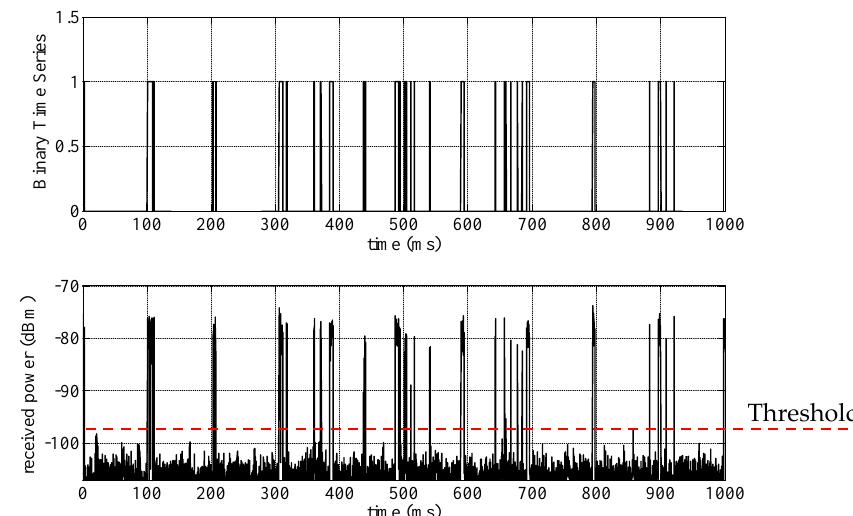
Figure 4. Mapping from received power to Binary Time Series in channel ‘1’.